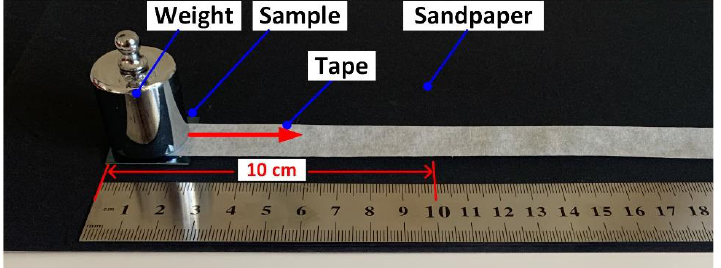
Figure 2. Schematic illustration of the experimental setup for the scratch test in this research